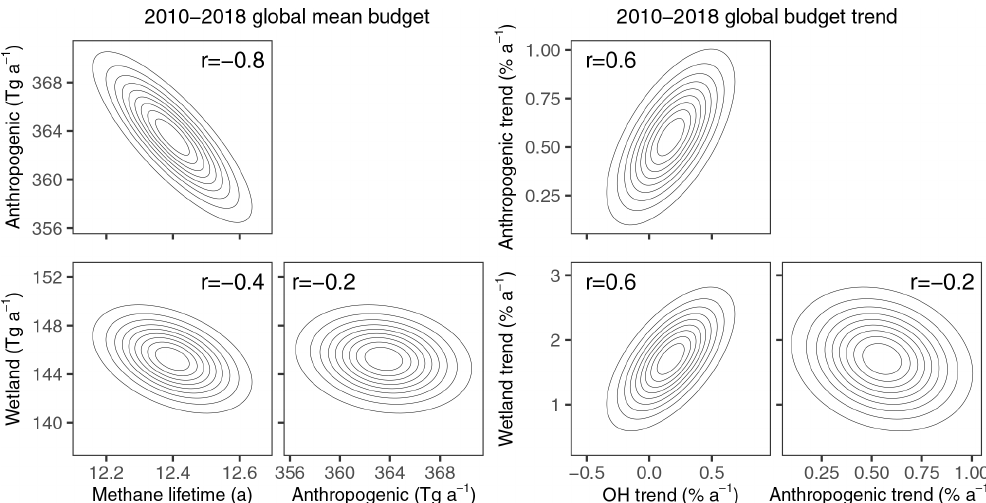
Figure 5. Error correlations between global anthropogenic emissions, wetland emissions, and tropospheric OH concentrations (methane lifetime against oxidation by tropospheric OH; τ ) in the inverse solution. Results are shown for both 2010–2018 mean values and 2010–2018 trends. The error correlations are presented as joint probability density functions for pairs of reduced global state vector elements. Confidence ellipses represent a probability of 0.1 (innermost) to 0.9 (outermost) at intervals of 0.1. The error correlation coefficients are